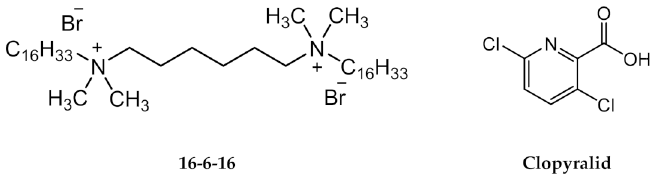
Figure 1. Structural formulas of hexanediyl-1,6-bis(dimethylcetylammonium bromide) (16-6-16) and